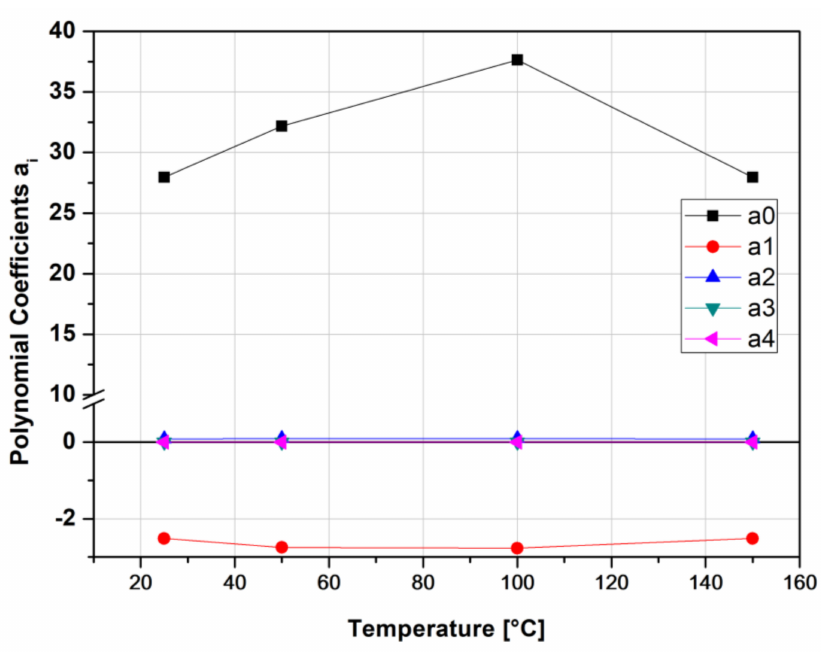
Figure 10. Vectran/aluminum–glass composite hybrid, polynomial constants as a function of refer- ence temperature Tref.